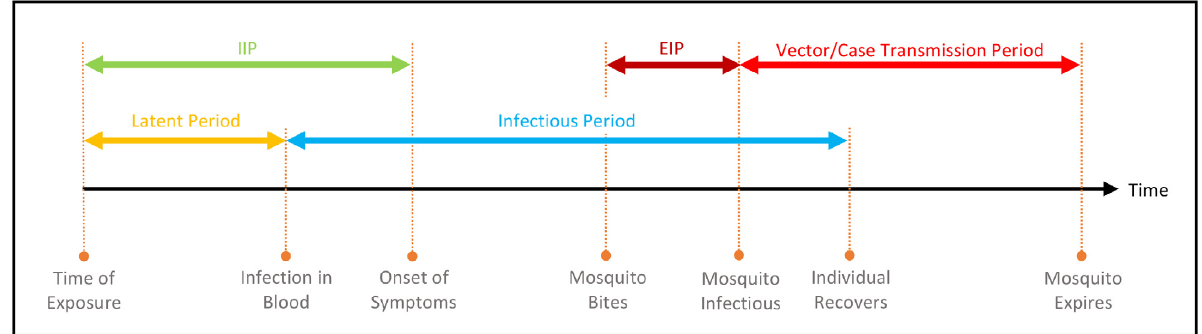
Fig 1. Dengue infection timeline. The blue, yellow and green arrows depict the dengue infection timeline in a human, while the two red arrows depict the same for a mosquito. A human undergoes a latent, intrinsic incubation (IIP) and infectious period indicating the time span during which it is infected: but not infectious, but not showing symptoms, and infectious, respectively. A mosquito undergoes an extrinsic incubation (EIP) and transmission period during which it is infected: but not infectious, and infectious, respectively. A case transmission period is an aggregation of all vector transmission periods associated with the case that starts with the earliest concluding EIP and ends with the death of the last infected mosquito.